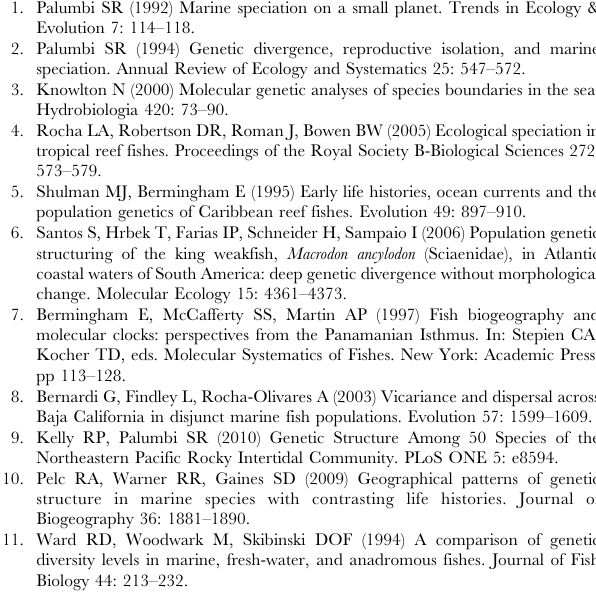
Figure 5. Geographic configuration of Colombia and bathymetric profile of the Southern Caribbean. (A) Present configuration (modified from [72]). (B) Early Pleistocene paleogeographic reconstruction (after [65]). Arrows indicate the narrow vs. wide continental shelf adjacent to the Santa Marta Massif in present vs. early Pleistocene times, respectively.